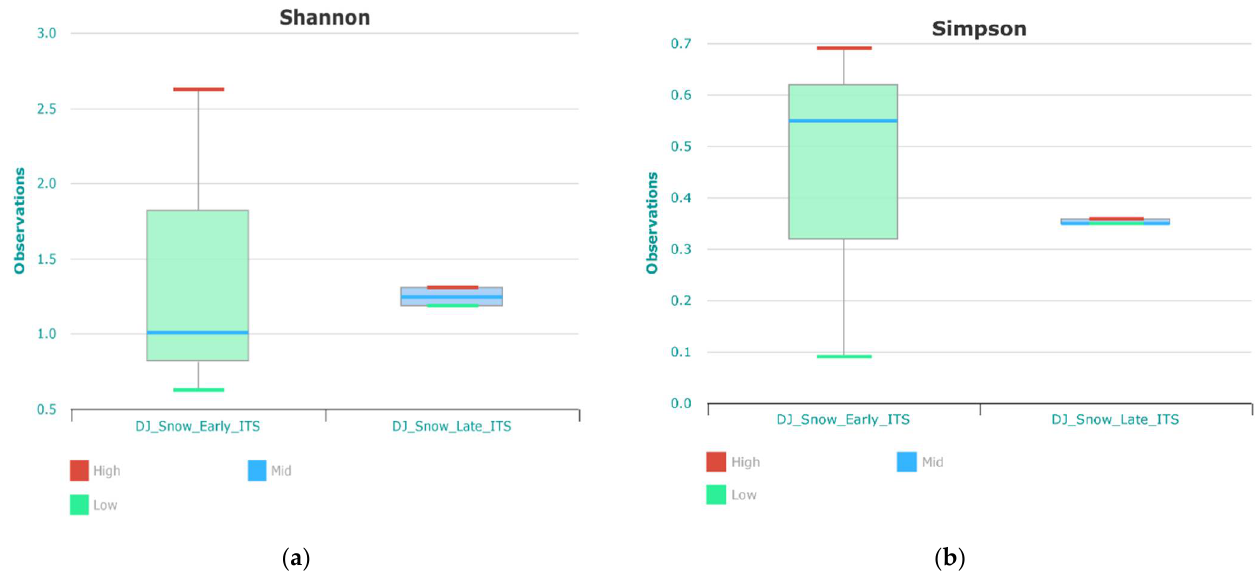
Figure 3. The average relative abundance of the major fungal phyla in the fresh snowfall samples.